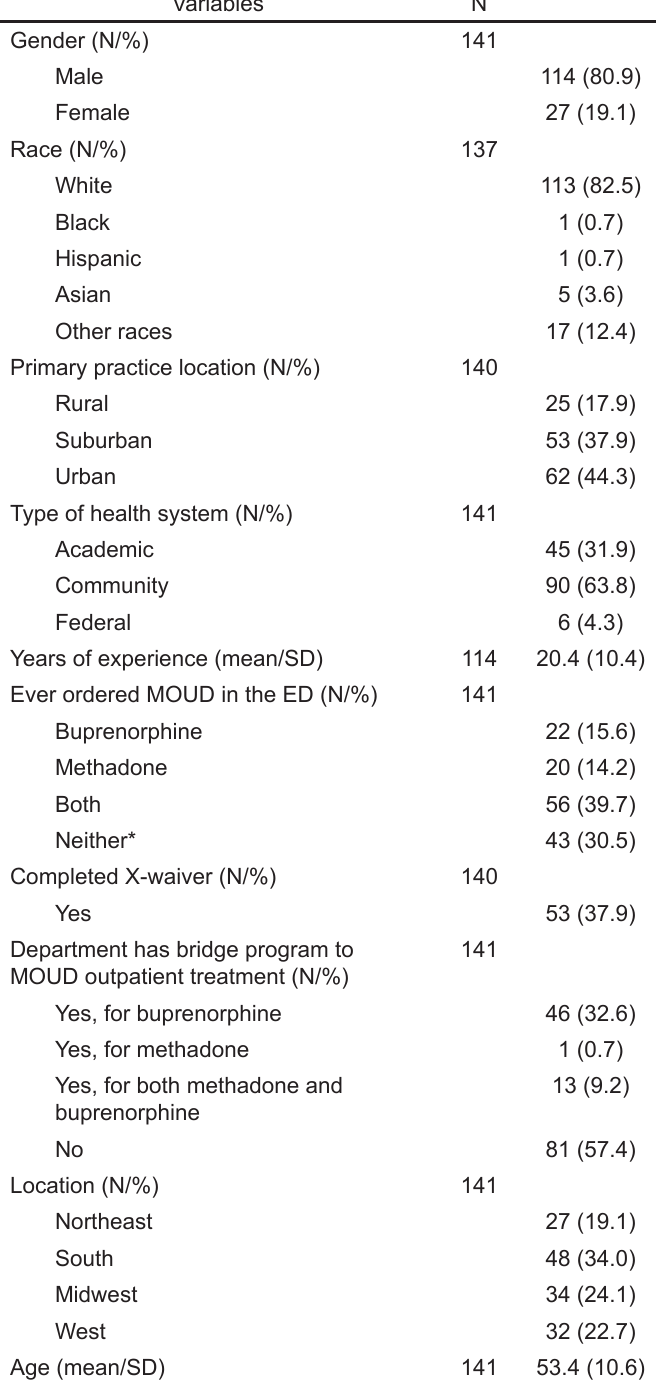
Table 1. Sociodemographic characteristics of emergency physicians with experience prescribing medications for opioid use